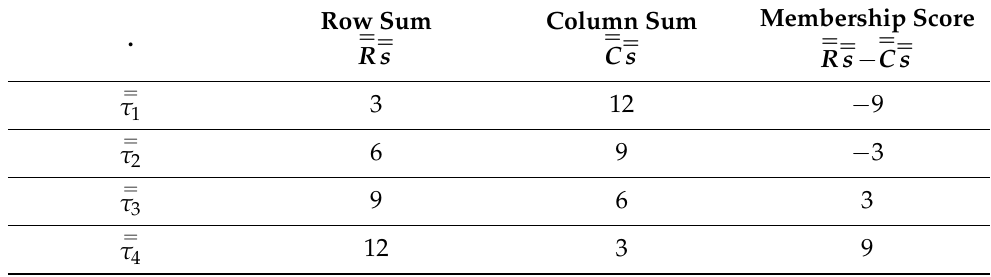
Table 8. PTG score table scenario 1.